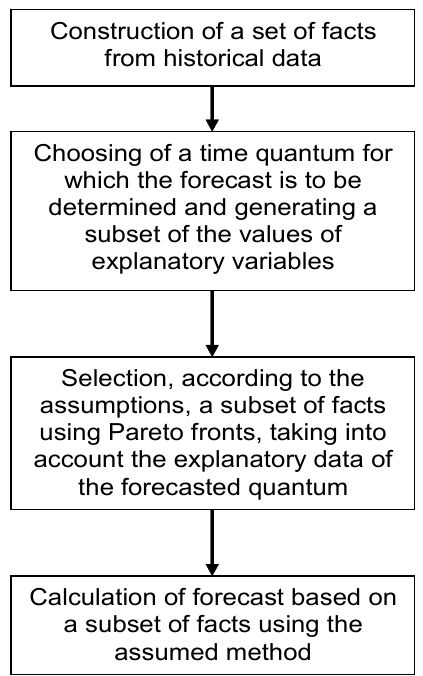
Figure 2. General idea of using Pareto fronts for forecasting.